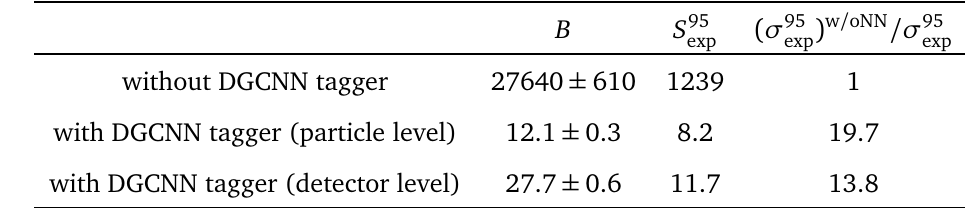
Table 3: Expected number of background events with systematic errors and expected limit on the number of signal events in the signal region EM4 at an integrated lumi- − 1 nosity of 36.1 fb . Listed are the event numbers for the mono-jet search without a dark shower tagger, with a DGCNN tagger operating on particles, and with a DGCNN tagger operating on detector level objects. For each case we also state the correspond- ing improvement of the expected limit on the dark shower production cross section. The DGCNN was trained and tested on a dark shower signal with our benchmark parameters (see main